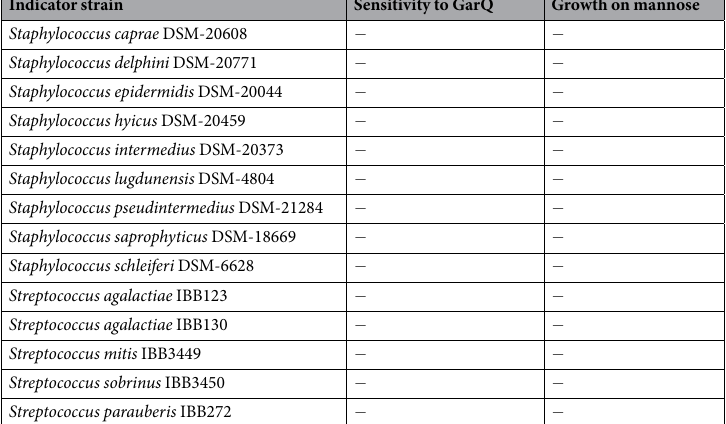
− − Table 1. Inhibitory spectrum of GarQ and bacterial ability to utilize mannose. “ − ” indicates that no inhibition zone was observed, “ + ” indicates that an inhibition zone in diameter less or equal to 10 mm was observed, while “ ++ ” indicates that an inhibition zone in diameter larger than 10 mm was